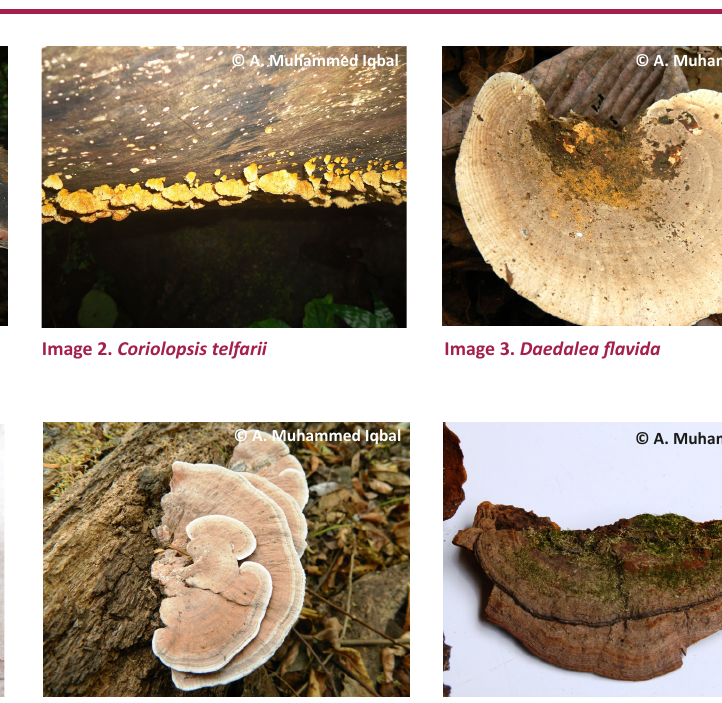
Image 5. Fomitopsis